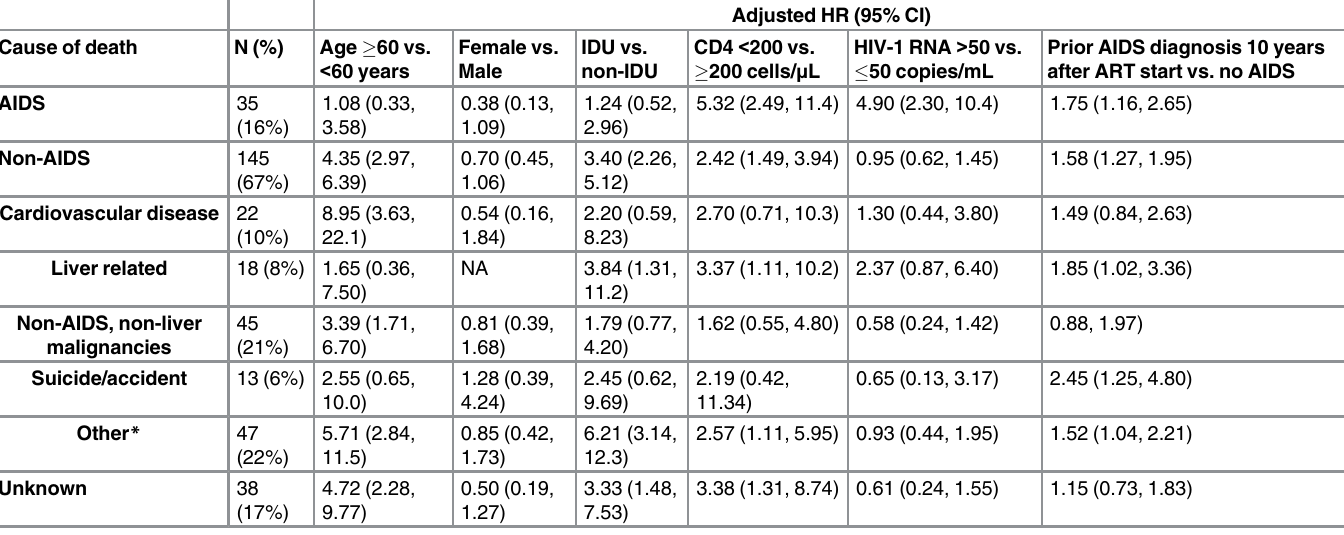
Table 6. Adjusted hazard ratios (HR) for specific causes of death, adjusted for all variables in the table and stratified by cohort, deaths =